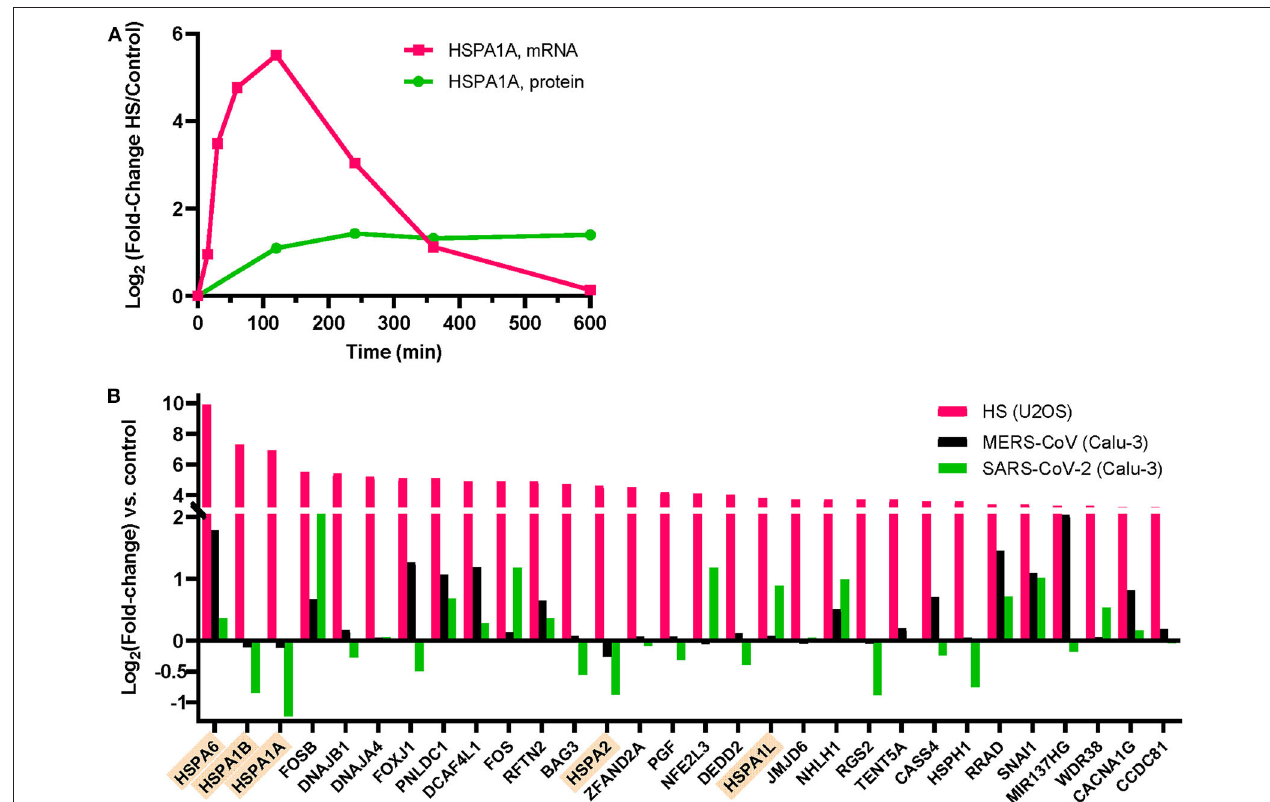
FIGURE 3 | Expression of heat shock proteins (HSPs) in human cells following heat-treatment at 42 ◦ C or MERS-CoV infection. (A) HSPA1A mRNA (pink) and protein (green) expression in Jurkat cells during a 4h HS at 41 ◦ C, followed by 6h at 37 ◦ C [data from (45)]. HSPA1A mRNA induction is maximal at 2h HS and thereafter decreases despite the ongoing HS for another 2h. (B) Normalized induction levels of the 30 most heat-induced genes by heat shock (42 ◦ C) in U2OS cells (pink) [data from (50)], by MERS-CoV infection (black) of human bronchial epithelial Calu-3 cells (black bars) [data from (51)], or by SARS-CoV-2 infection of Calu-3 cells (green bars) [data from ( 52)]. Cytosolic HSP70s are indicated in